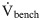
Linear regression, Bland and Altman analyses of apnea duration determined from respectively bench airflow and polygraph nasal airflow (149 apneas).Only the apneas detected both in bench airflow (V˙bench) and in polygraph nasal airflow (V˙source) are taken into account. (a): linear regression analysis between apnea duration determined from V˙source (Tapnea-source in x-axis) and the one from V˙bench (Tapnea-bench in y-axis). Red line: the linear regression line. Black line: the identity line. (b): Bland and Altman analysis of agreement between Tapnea-source and Tapnea-bench.